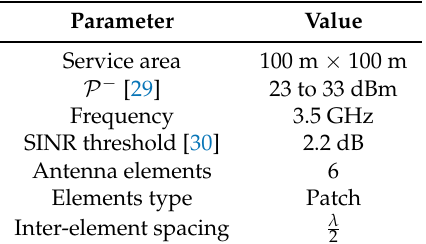
Table 1. Simulation settings.